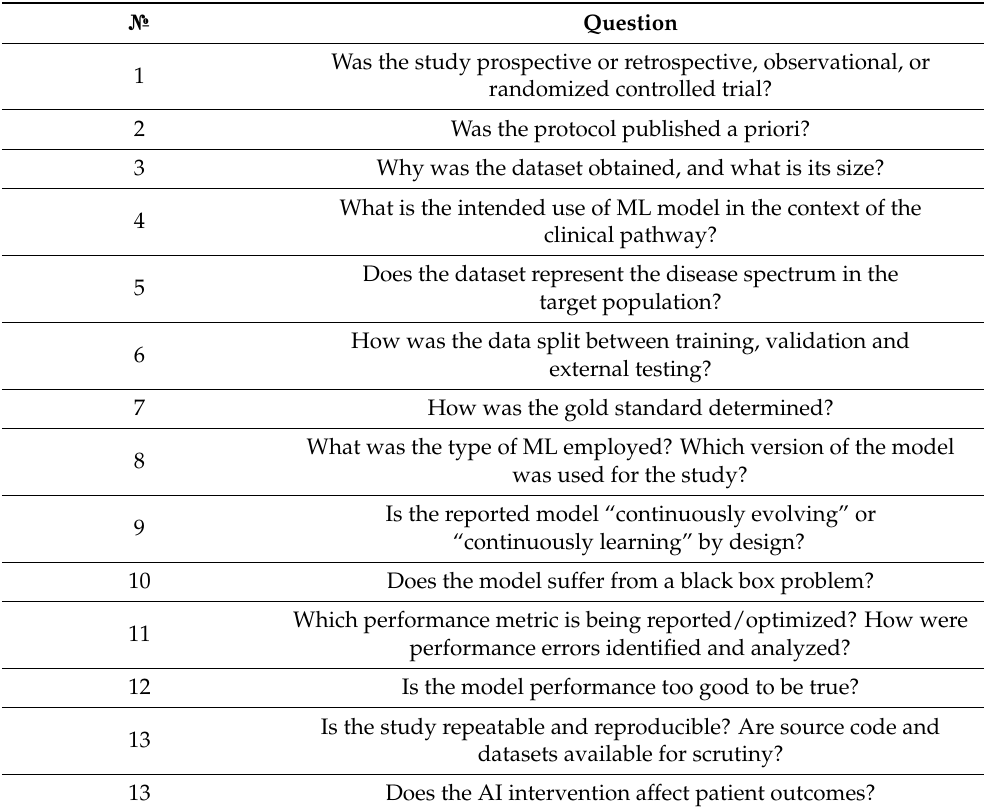
Table 6. Summary of key questions in critical appraisal of a machine learning research paper